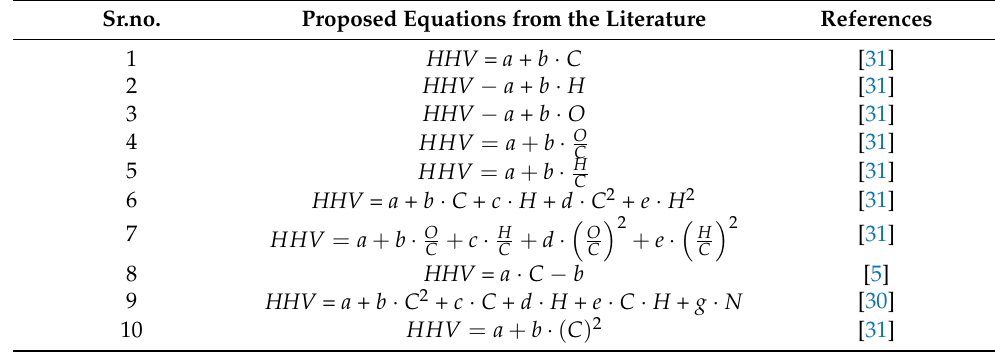
Table 1. List of equations for calculating